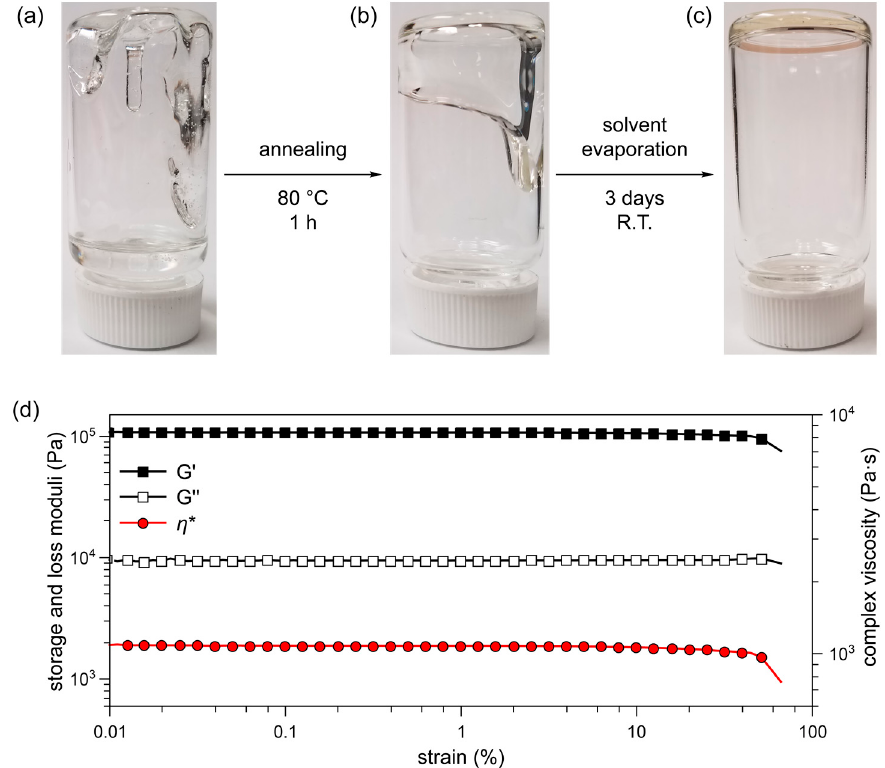
Figure 4. Photographs of PY-PSBTh physical blend: ( a ) soon after the PDMS/PS toluene solutions are mixed (notice the solvent phase separated from the organogels); ( b ) homogeneous and viscous organogel after annealing at 80 °C for 1 h; and ( c ) final PDMS/PS blend after solvent evaporation, PY-PSBTh; ( d ) Strain sweep (100 rad/s at 25 °C) of PY-PSBTh dry gel ( d ).